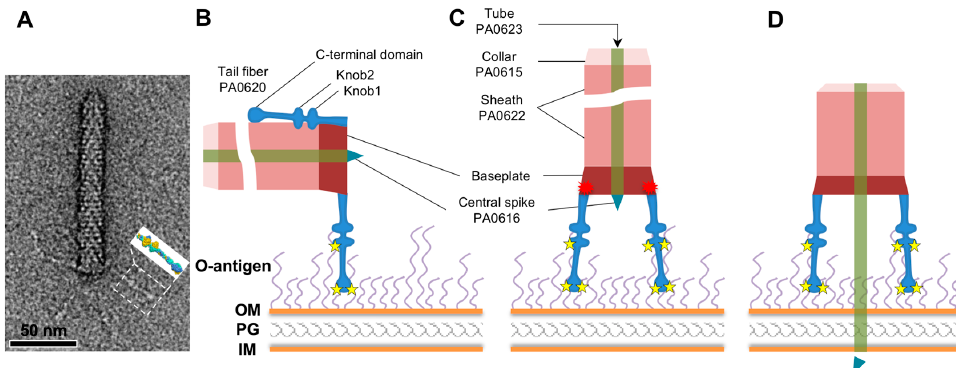
Figure 8. Function of the fiber in triggering sheath contraction. ( A ) A particle of R2 pyocin negatively-stained with uranyl acetate and imaged in a transmission electron microscope. The inset shows the molecular surface of the fiber fragment structure determined by X-ray crystallography. ( B ) Two spatially separated substrate-binding sites cause the fiber to bind at a certain angle relative to the cell surface. Here, the fiber is shown to be perpendicular to the cell surface, but the actual angle is determined by the structure of the substrate. ( C ) Binding of the second and subsequent fibers to the host cell surface requires their orientation relative to the cell surface to be identical or very similar to that of the first fiber. This requirement also orients the pyocin particle to be perpendicular to the cell surface. The configuration of the baseplate with all the fibers pointed towards the cell surface is unstable and causes it to initiate sheath contraction.